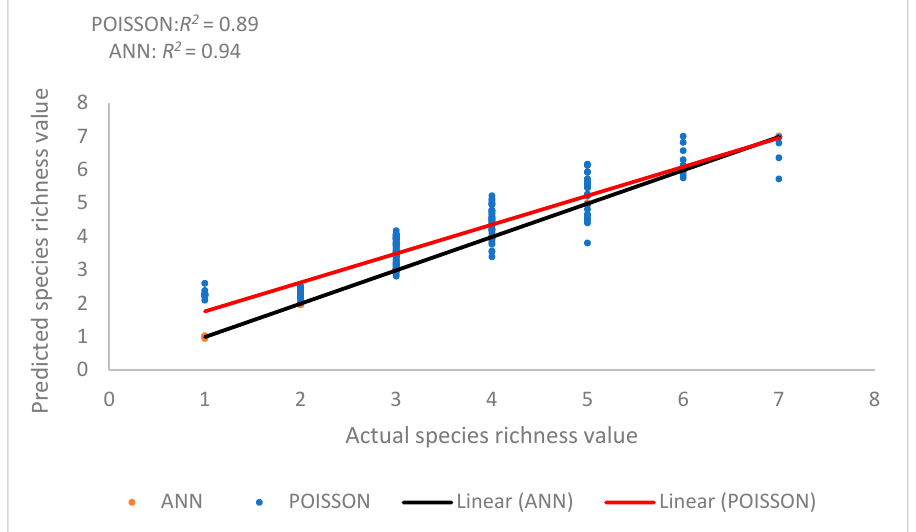
Figure 8. Relationship between predicted and actual SR values Poisson regression (red line), and nonparametric methods (ANN (black line)).